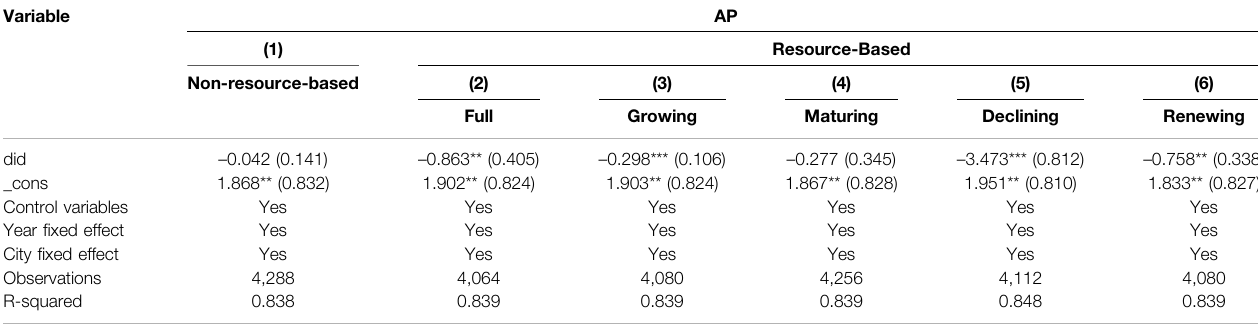
TABLE 6 | Selection of pilot cities based on resource endowments.